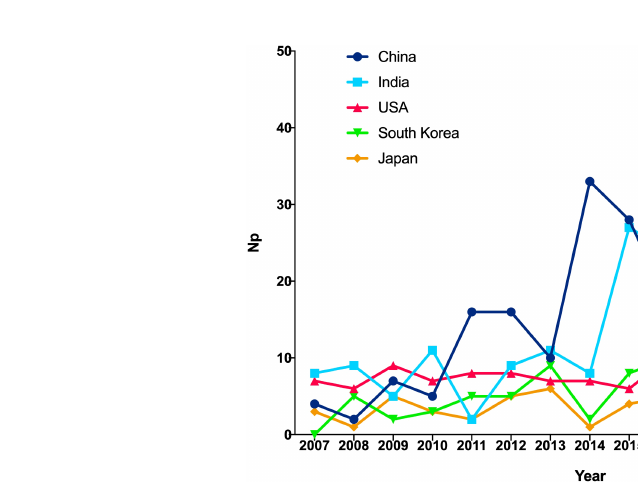
FIGURE 2 The number of publications by year over the past 10